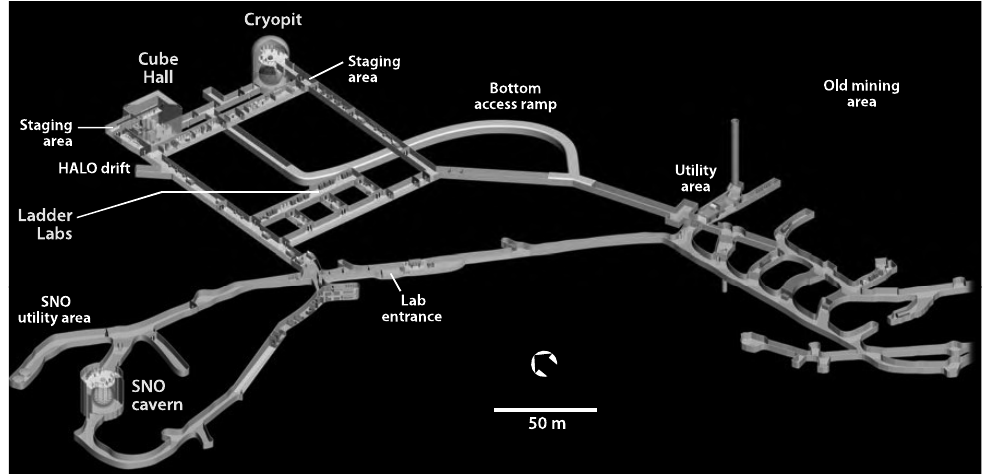
Figure 1. A 3D model of the SNOLAB in Sudbury, Ontario, Canada (image credit: [14]). Scale and direction to the geographical north are also